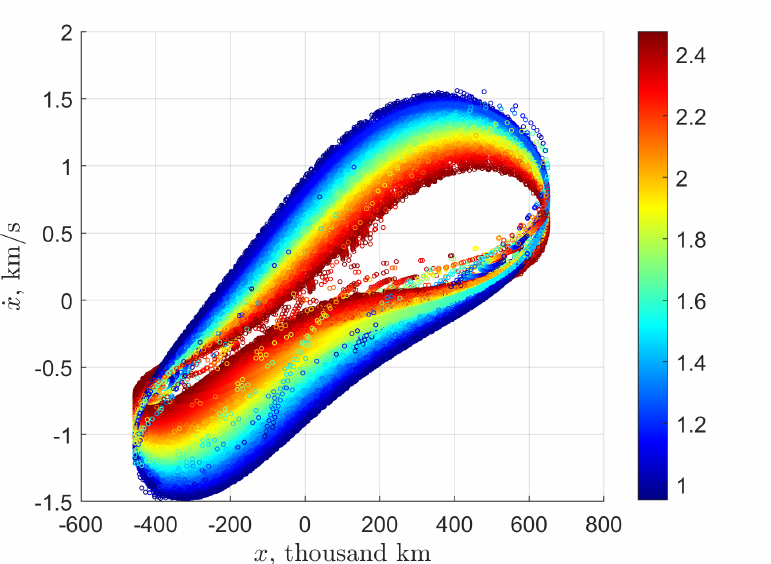
Figure 10. Earth–Moon RoP re-entry conditions for candidate exterior legs. The color reflects the Jacobi integral value at re-entry. The points with J > 2.47 are not displayed because it is unfeasible to patch the associated exterior legs with any departing